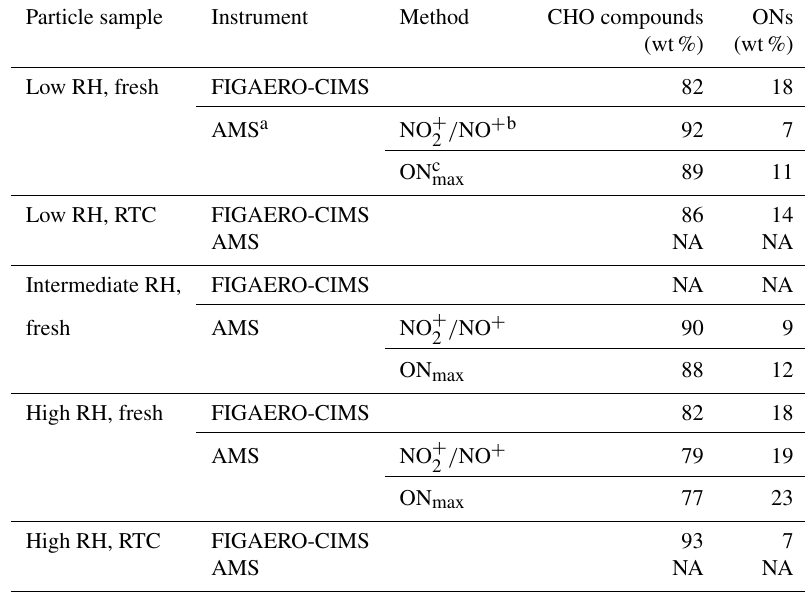
Table 1. Mass contribution of CHO compounds and ONs to the α -pinene SOA particle samples formed under high NO x conditions in the